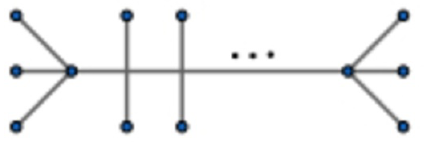
Figure 13 . The quartic graph whose corresponding Stokes polytope is the hypercube. The quad- rangulation corresponding to this case has only parallel diagonals